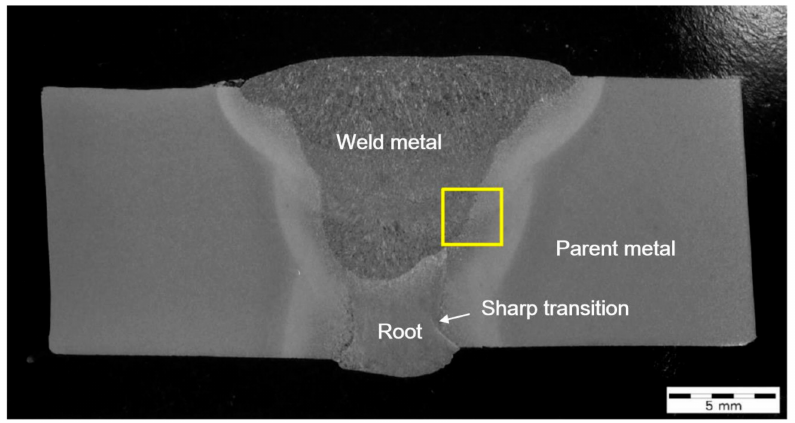
Figure 2. Macro section W01-04 of the 12 o’clock region of the FCAW girth weld.